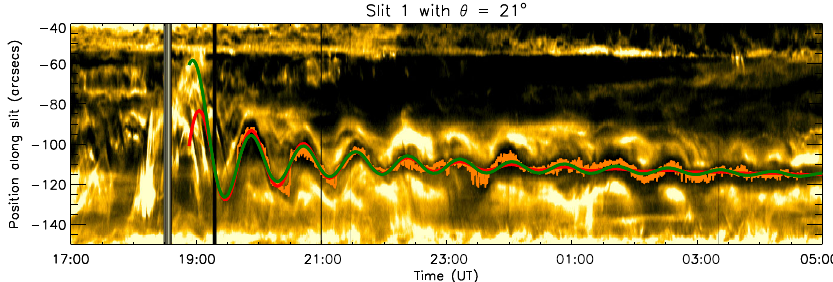
Fig. 4 Time–distance diagram. The fitted functions are plotted as red and green lines corresponding to the exponentially decaying sinusoid and the Bessel function, respectively. Image reproduced with permission from Luna et al. (2014), copyright by